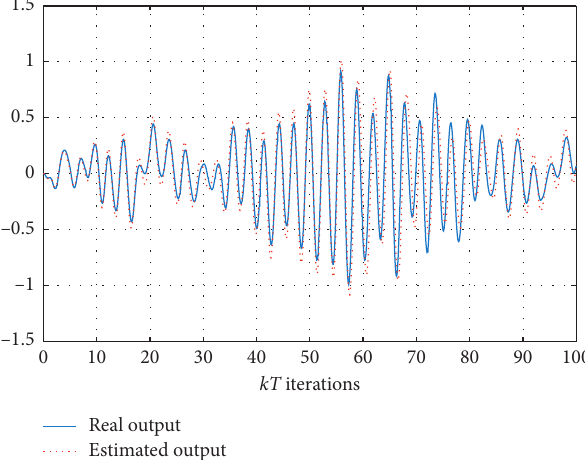
Figure 4: Response of the yaw angle of the open-loop